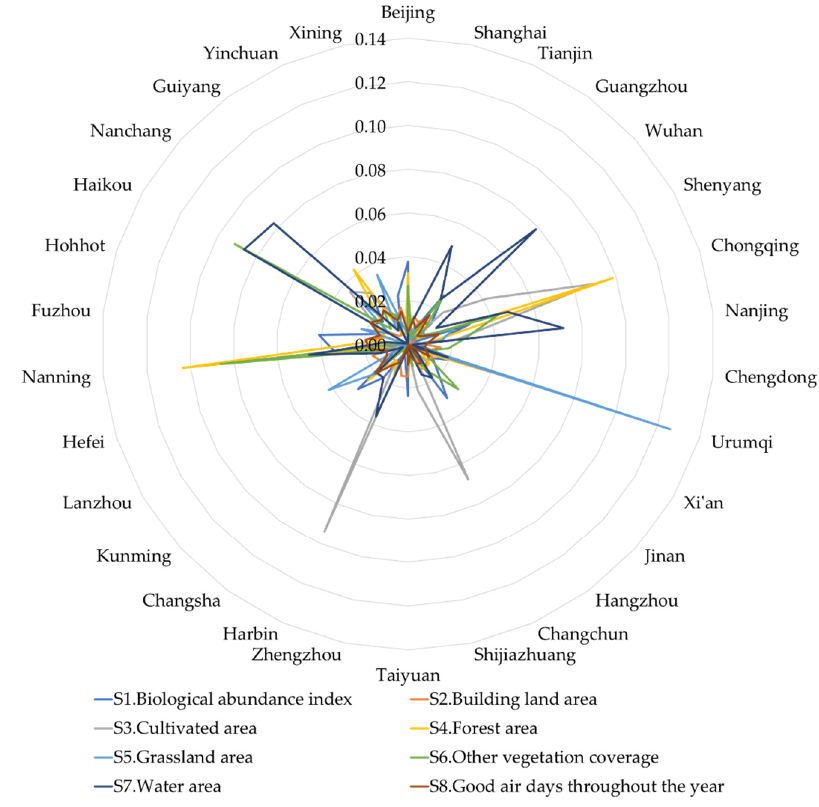
Figure 8. Weighted comparison of sub-indicators in state index.